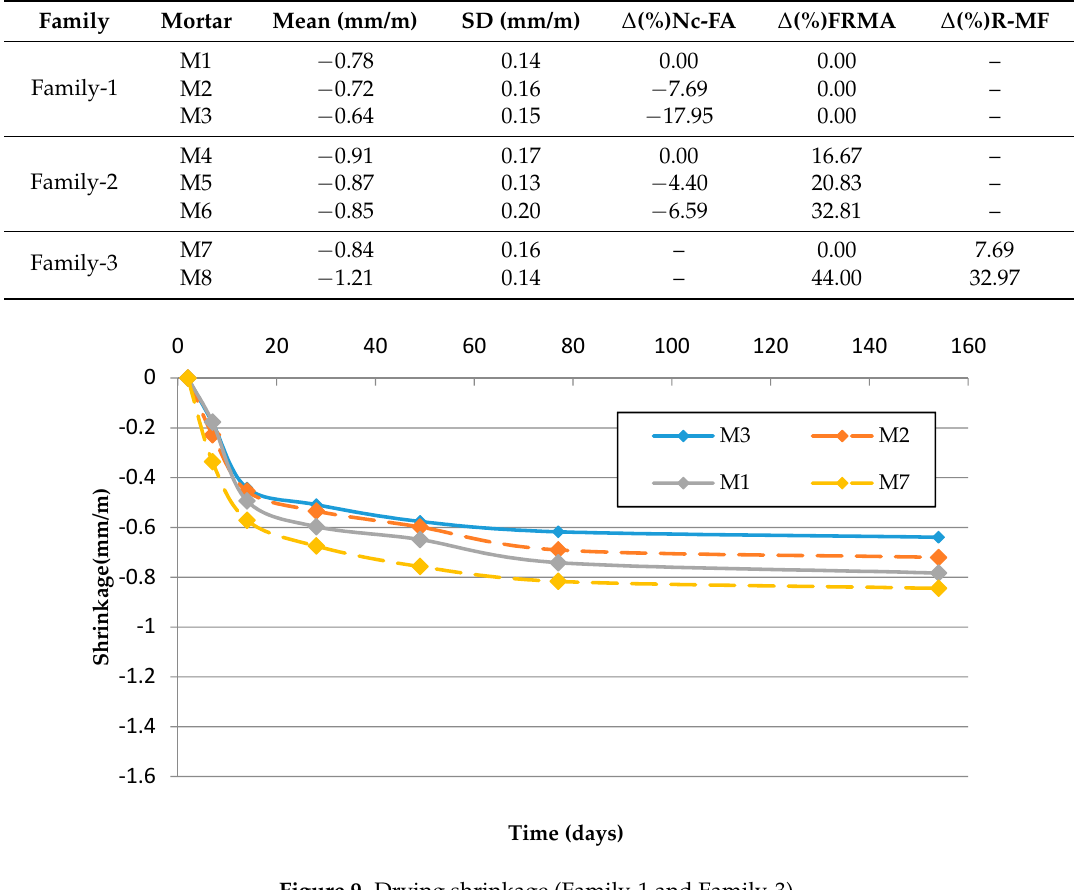
Figure 9. Drying shrinkage (Family-1 and Family-3).